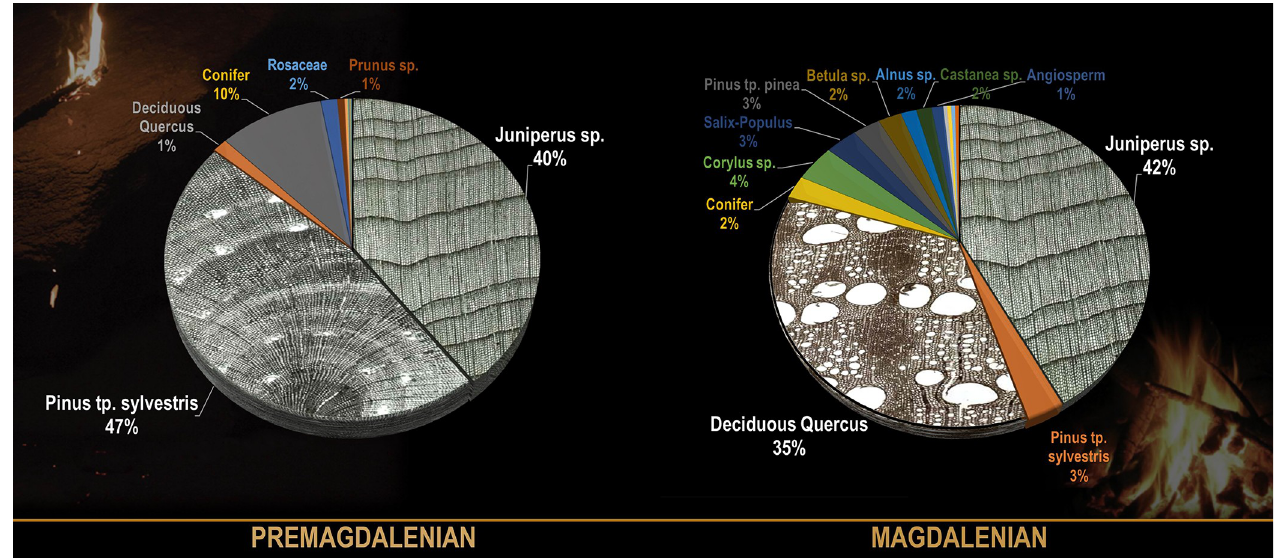
Fig 2. Anthracological data from Paleolithic light systems (torches and fireplaces). For more information: S1 Appendix . Wood transversal section images: www.woodanatomy.ch.